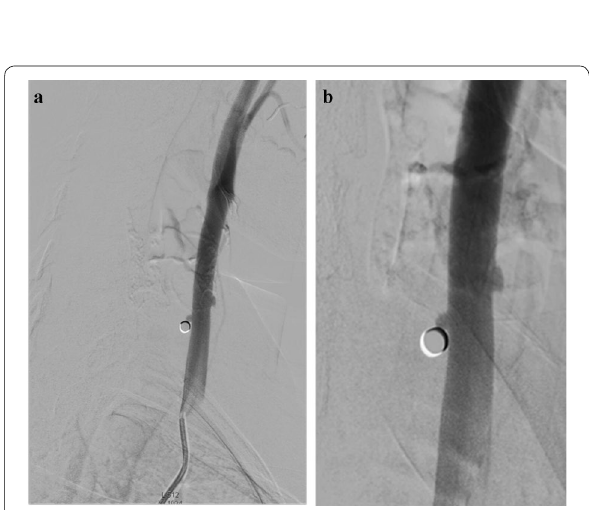
Fig. 4 a , b Views of angiography of the left carotid artery showing the two pseudoaneurysms and bullet